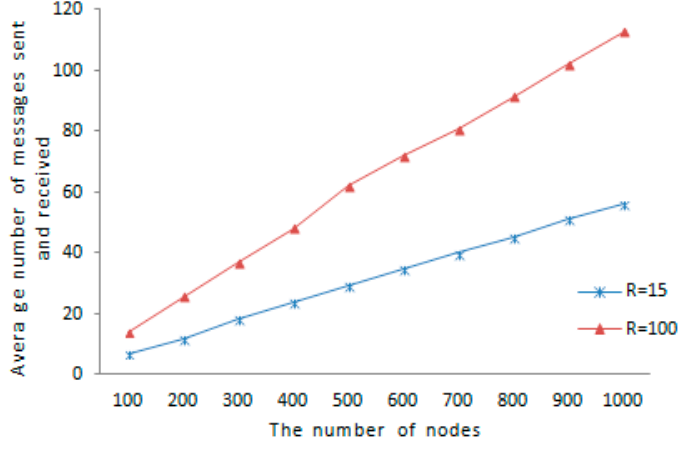
Figure 12. Communication overhead.